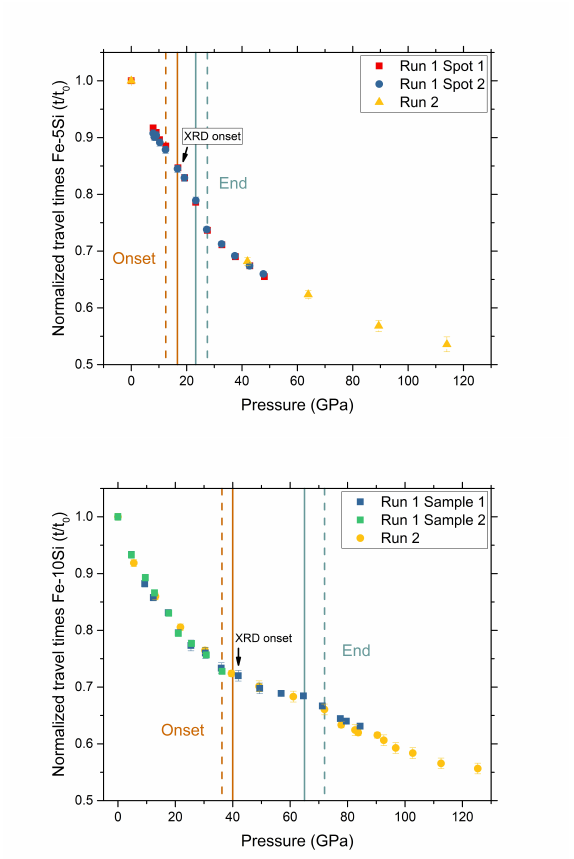
Figure 4. Normalized travel time t / t 0 vs P for different runs on Fe5Si ( up ) and Fe10Si ( down ). The bcc-hcp transition results in a significant reduction in the scatter of the measured travel times for Fe5Si. We also note that sample tilt within the sample chamber has a negligible effect on measured travel times due to the instrumental configuration used. Run numbers indicate the number of each experimental run for a given alloy, and Samples 1 and 2 for Fe10Si indicate two separate samples co-compressed in one experimental